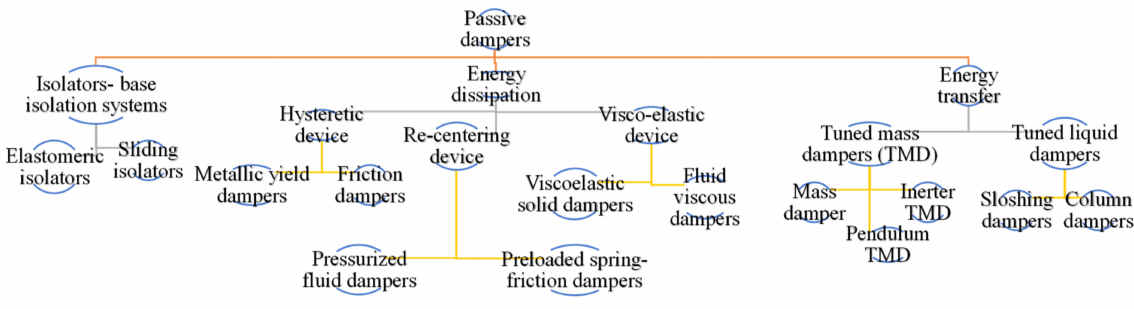
Figure 2. Division for passive